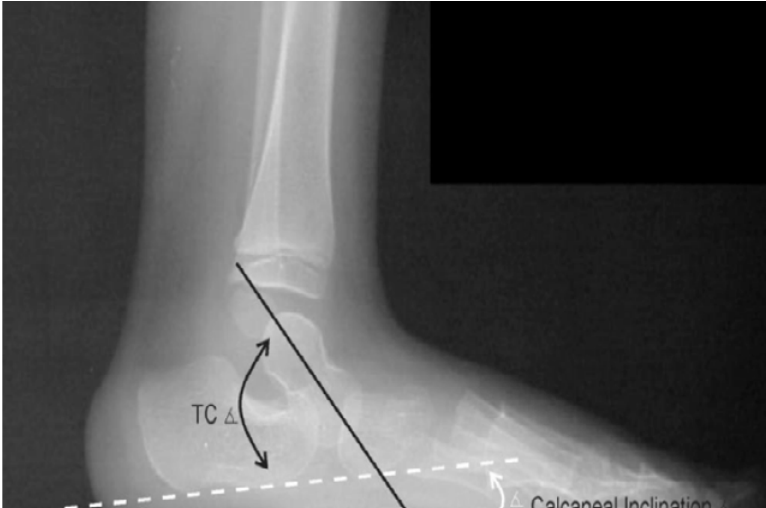
radiographic analysis, the radiographic parameters used were focused on the relation of the angle formed between the lower edge of the calcaneus and the ground (calcaneus inclination angle). Angles from 20° to 30° were regarded as a reference value for classifying the foot as normal; values smaller than 20° meant the foot was classified as pronated [5]